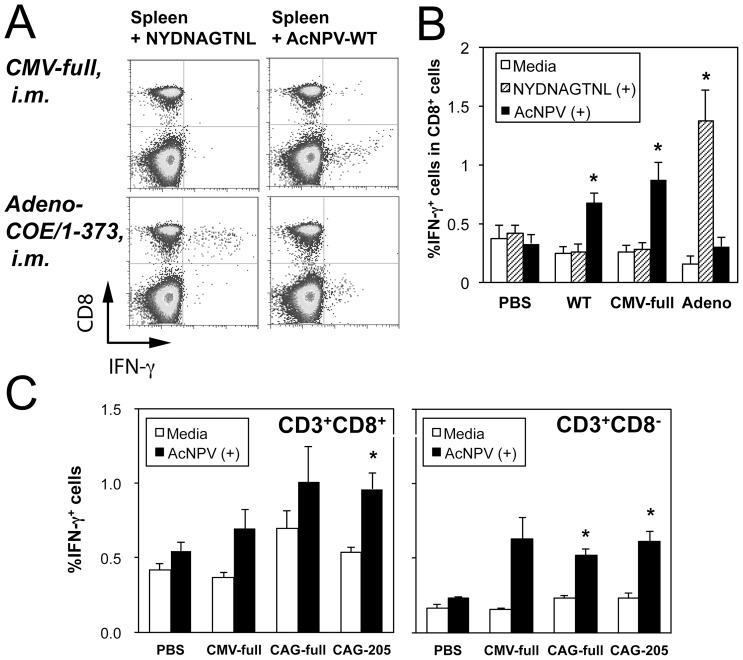
Intracellular cytokine staining of splenocytes from BDES-immunized mice.Groups of mice were injected with PBS or immunized intramuscularly (i.m.) with CMV-full, AcNPV-WT or Adeno-COE/1–373 (A) (B) (n = 6, experiment 5 in Table S1), or CAG-full and CAG-205 (C) (n = 3, experiment 6 in Table S1). Two weeks after the last immunization, splenocytes from each group were stimulated with either NYDNAGTNL peptides or AcNPV-WT at a MOI of 1 in duplicate wells of the cultures. After 24 hours, the incubated cells were stained with Abs against CD3 and CD8, and then stained intracellularly with anti-IFN-γ or its isotype control. (A) Representative dot plots are shown. (B) (C) Bars and error bars show the mean values and standard errors for the percentage of IFN-γ positive cells, respectively. Significant differences between non-stimulated media controls and stimulated wells were evaluated using Student's t-tests. * p<0.05.